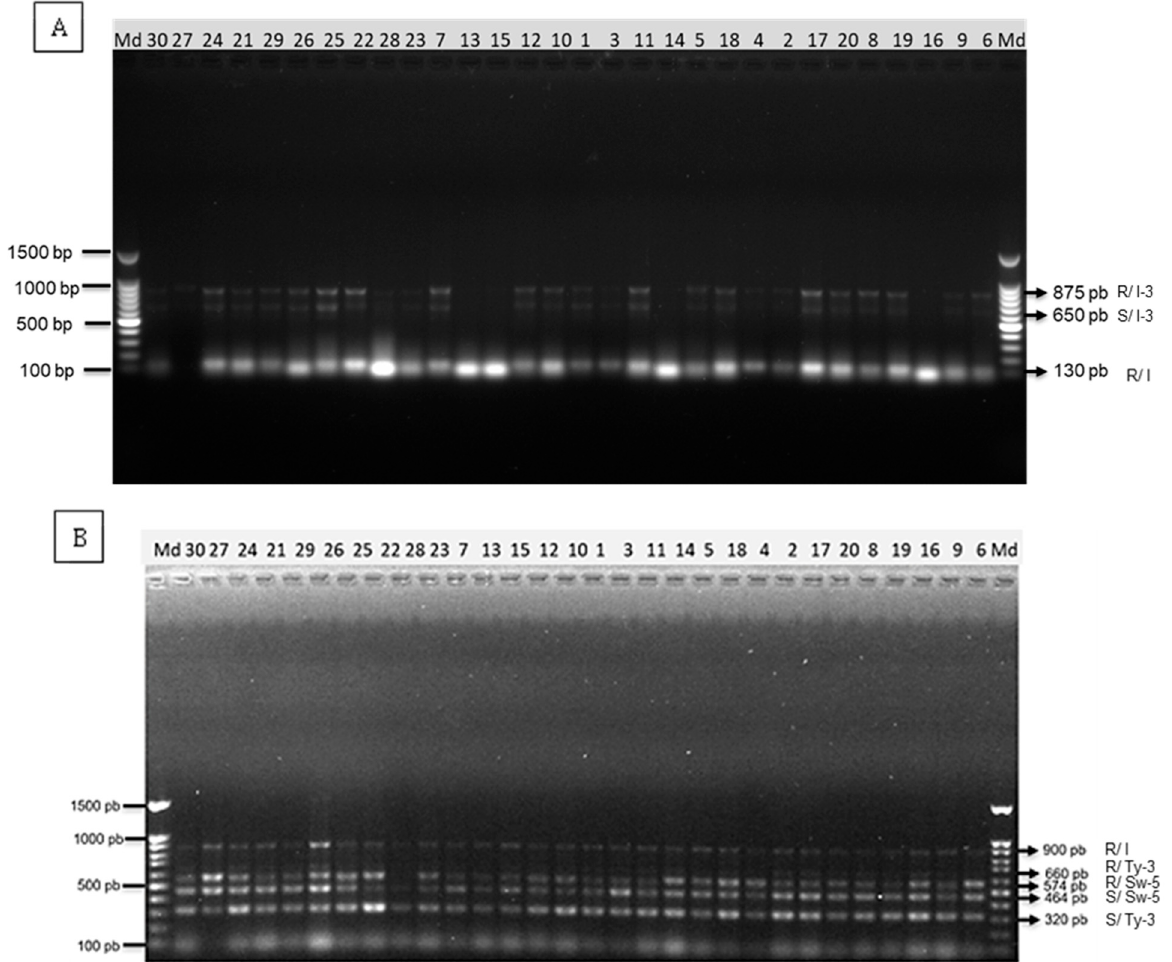
Figure 1. A 1% agarose gel electrophoresis of the amplifications ( A ) At-2 and P7-43; ( B ) SSR-67, Sw-5 and P6-25 markers. Md: 100 bp molecular weight marker. Number 1–30: Standard order of the runs (optimization).